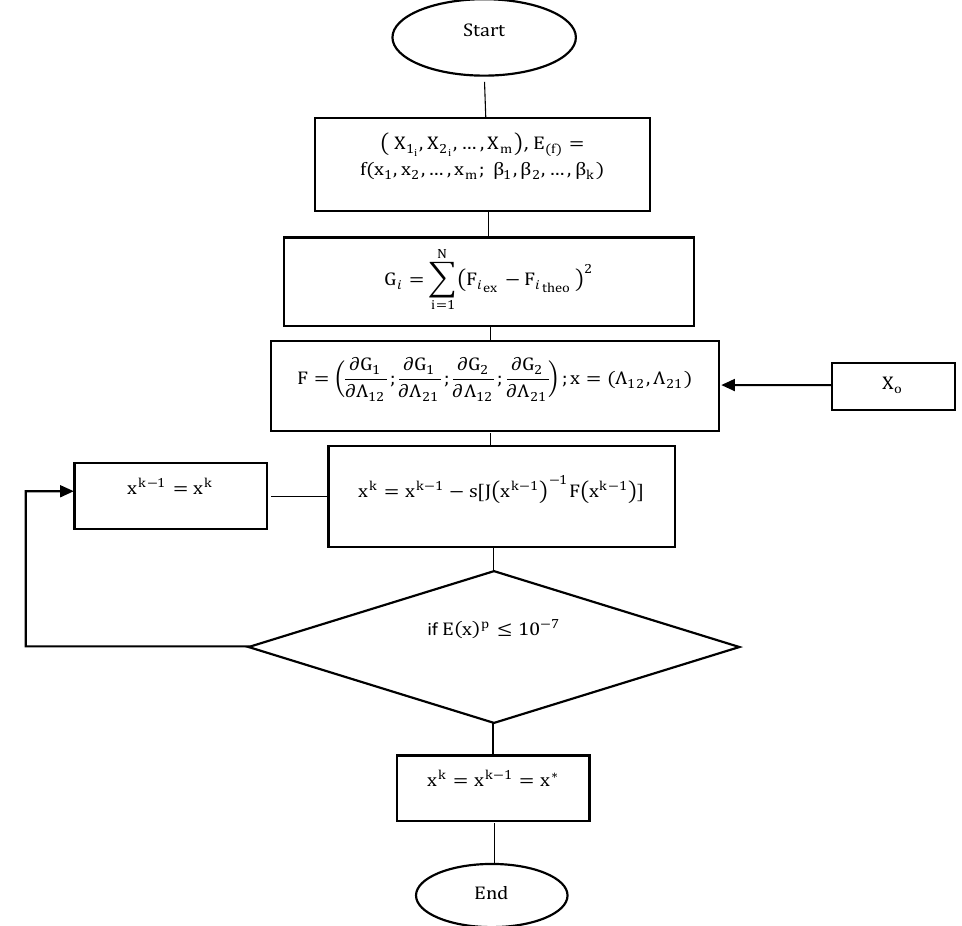
Figure 1. Proposed algorithm for the solution of the problem based on the Newton–Raphson method.